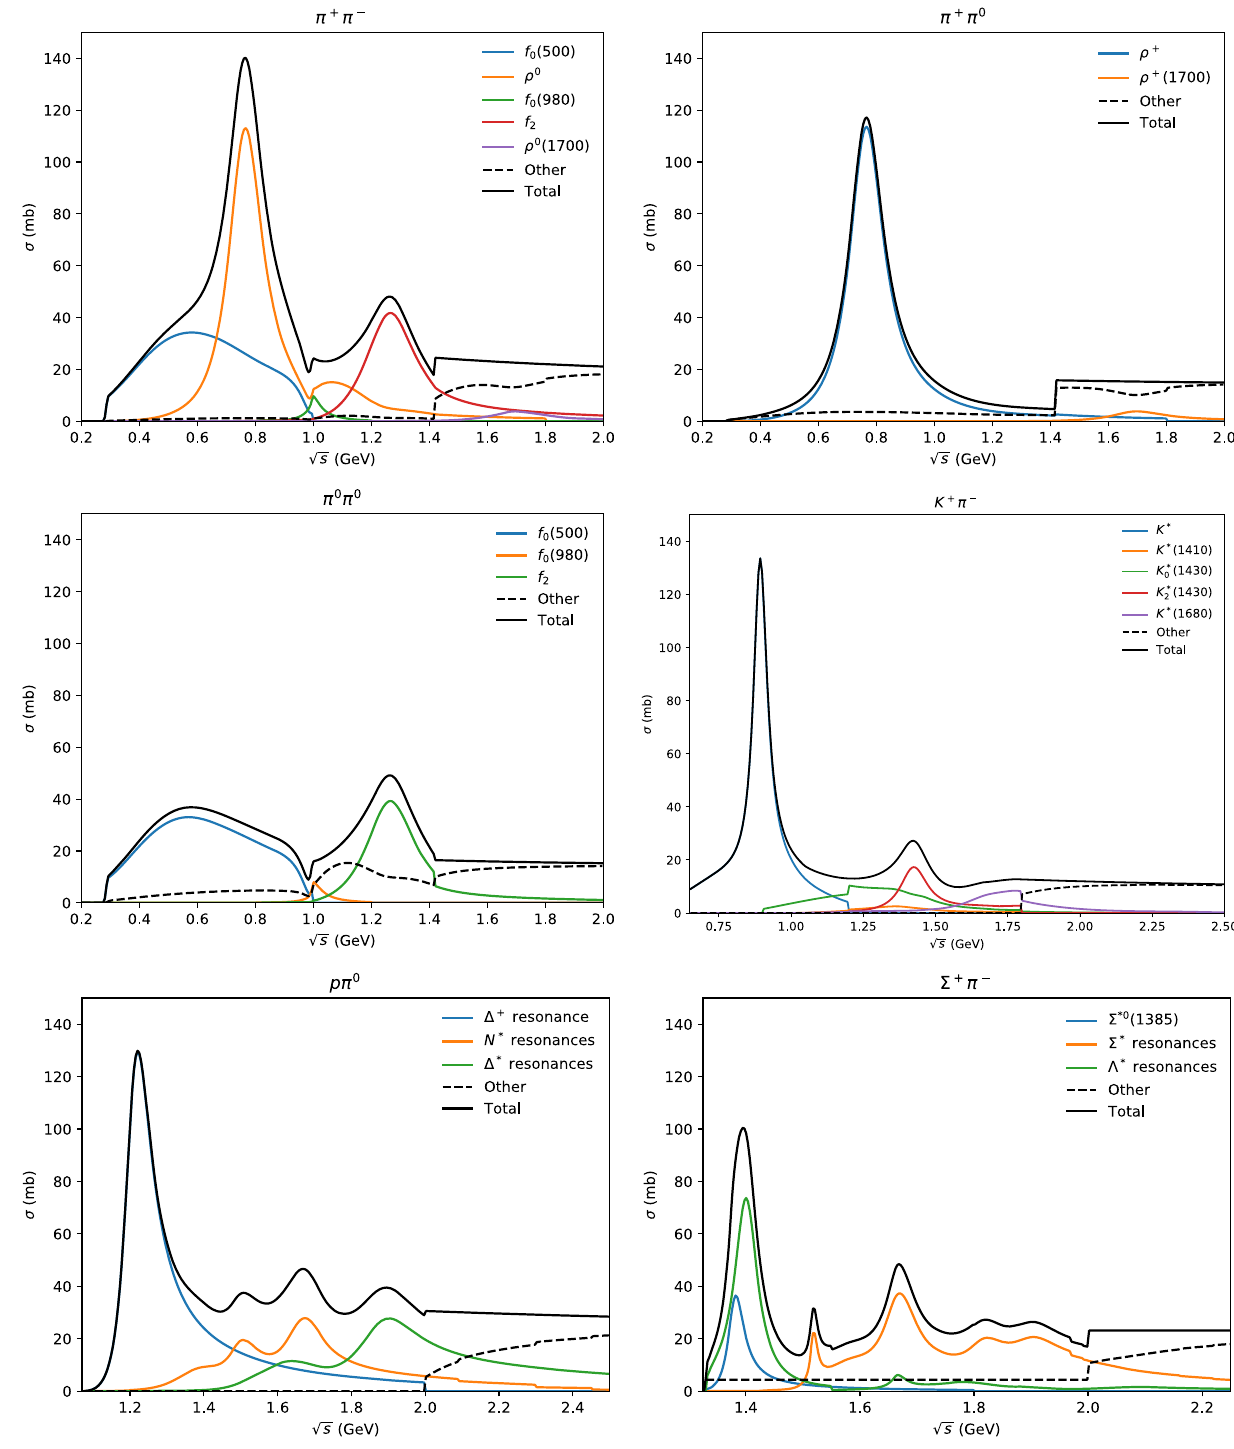
Fig. 4 Resonant cross sections for some important cases, with partial cross sections for each resonance. For p π 0 and Σ + π − there are many resonances, and we have divided them into groups for readability. The “other” cross sections include elastic, diffractive and